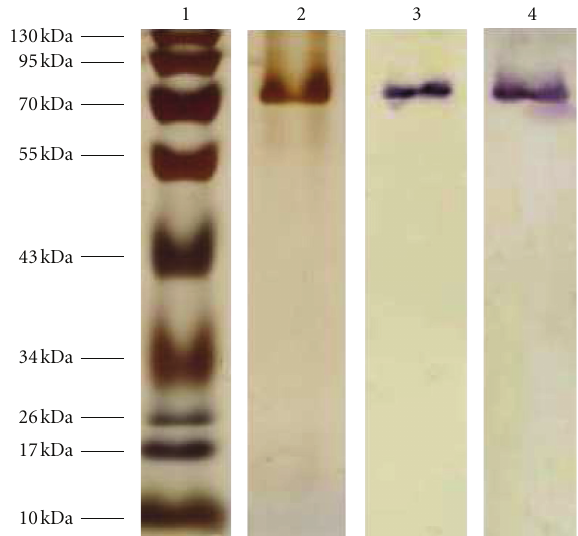
Figure 3: SDS-PAGE of purified β -glucuronidase. (1) Fermentas PageRuler molecular mass standard. Elution fraction 5 (0.7 μ g) of the β -glucuronidase produced in Ms. mazei was subjected to SDS- PAGE with subsequent visualization by silver staining (2), Western blot, and antibody-detection with anti-Strep antibody (3) and anti- GUSB antibody (4).